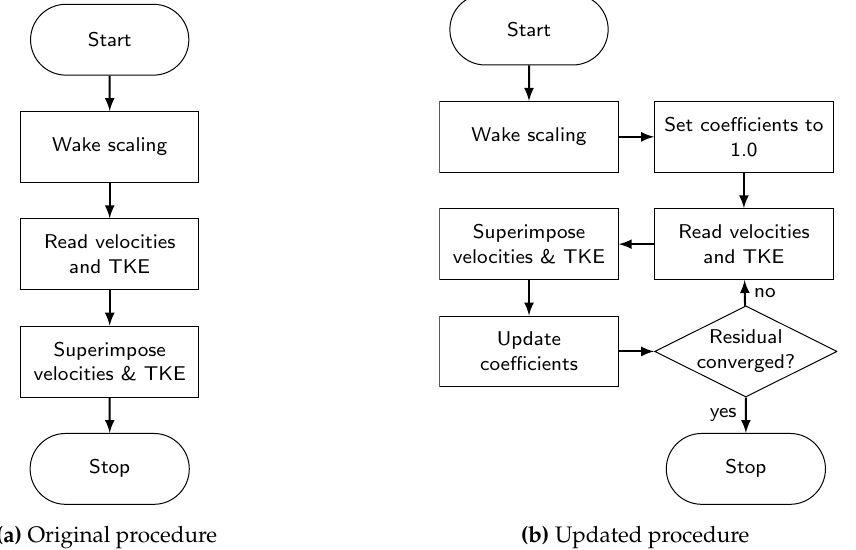
Figure 4. Calculation steps for determining the velocities and turbulence kinetic energies of the array TECs subject to wake interactions. The original process shown in (a) has been updated for this work, as shown in (b).